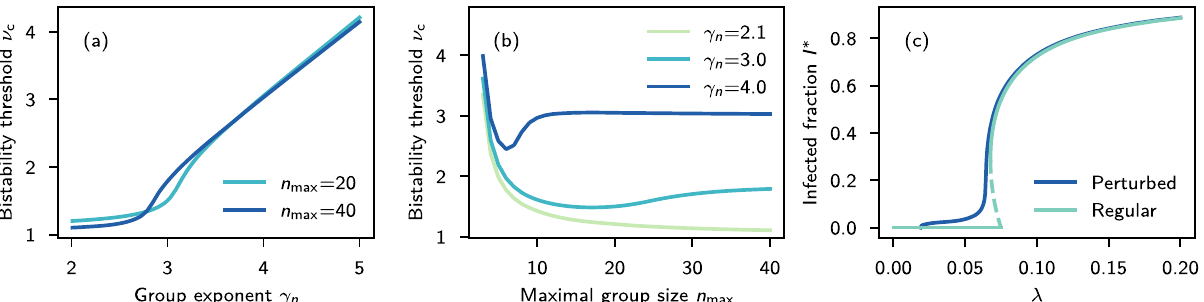
, the average stationary fraction of infected nodes in groups of various size n . We Fig. 8 Mesoscopic localization in large groups. We illustrate I (cid:4) n considered hypergraphs with power-law group size distributions p n (cid:5) n (cid:2) γ n with γ n = 3, regular membership distributions of the form g m ¼ δ m ; m is larger for larger groups in a with ν = 0.5, but localization is various exponents ν for the infection function in Eq. (1). Near the invasion threshold λ c , I (cid:4) n much more pronounced for b with ν = 1.5. c For discontinuous phase transitions, mesoscopic localization is still possible, but near λ c we must look at the in the bistable unstable solution for I (cid:4) n